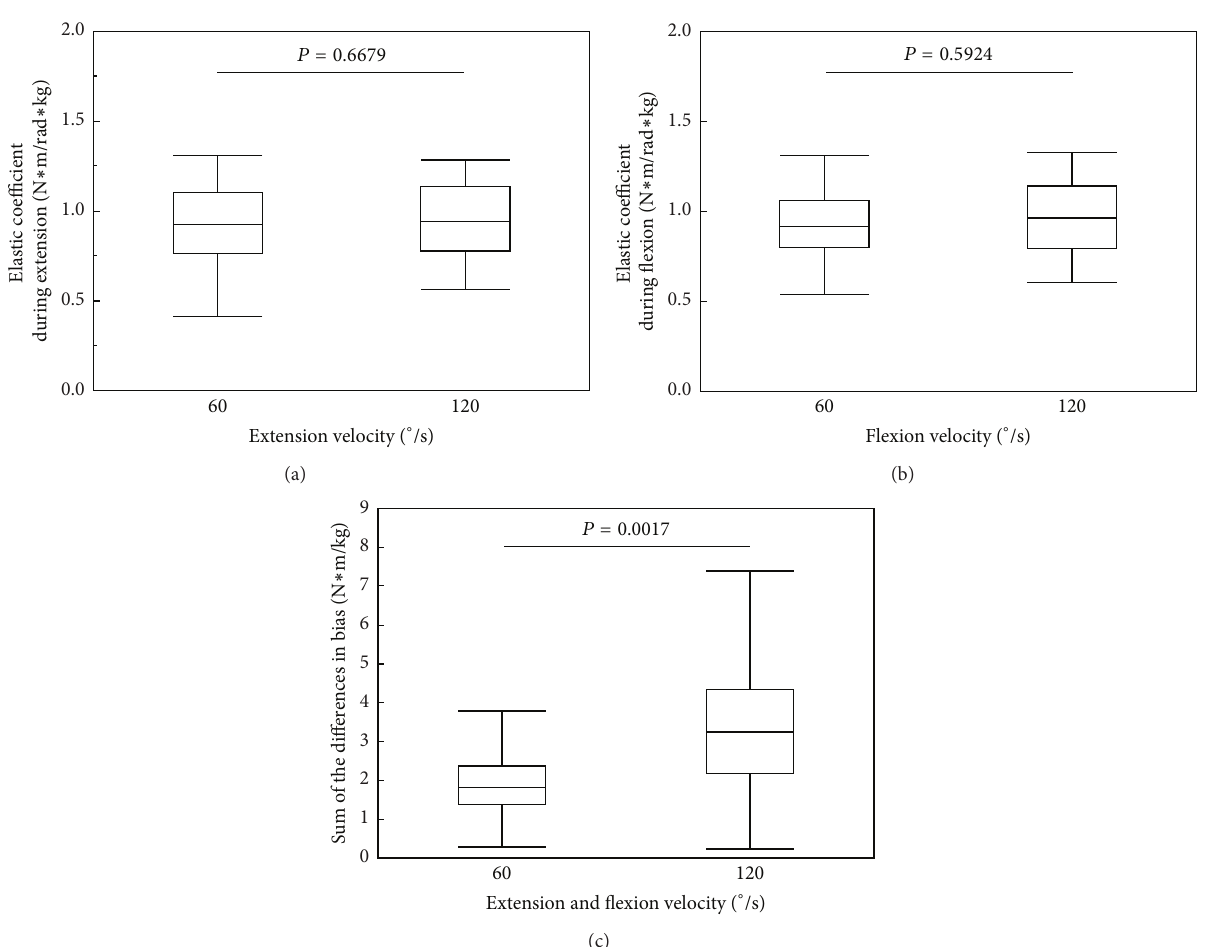
Figure3:Changesinthe(a)elasticcoefficientduringelbowextension,(b)elasticcoefficientduringelbowflexion,and(c)sumofthedifference in bias with changes in extension and flexion